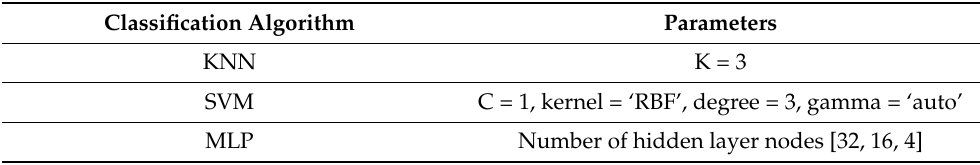
Table 1. Parameters of the three classification algorithms. Classification